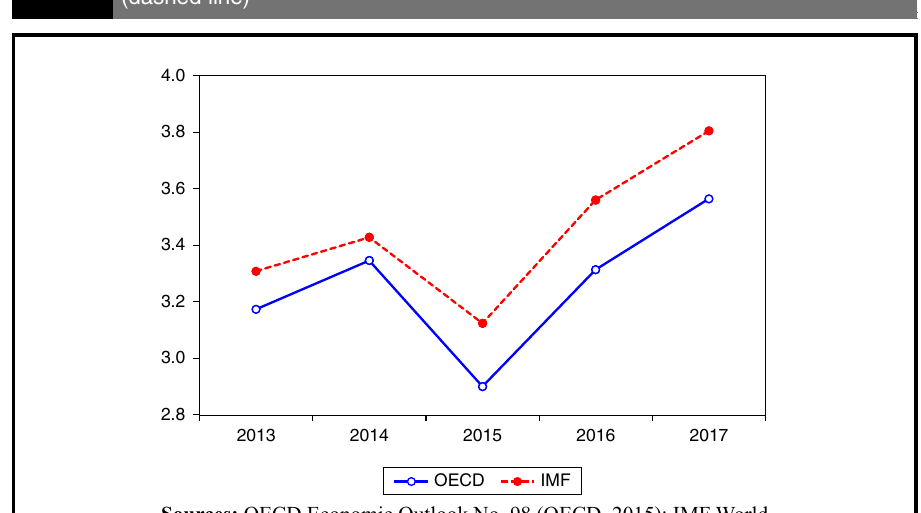
Figure 1 Annual global real GDP growth forecasts according to OECD (solid line) and IMF (dashed